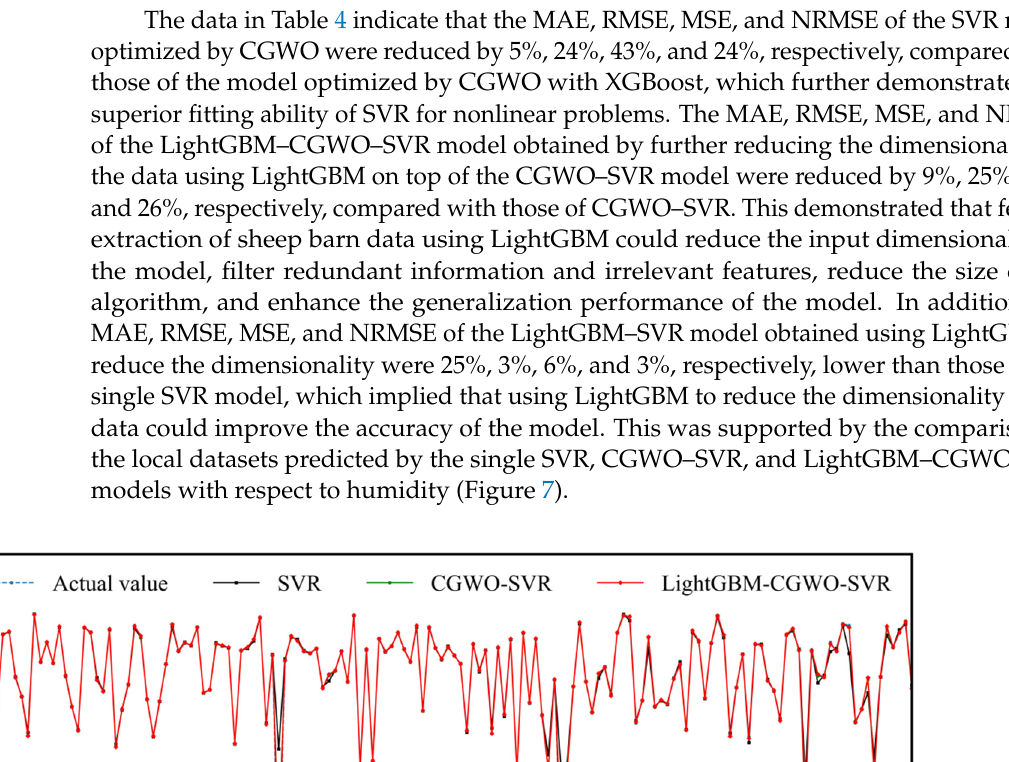
Figure 6. Measured versus computed humidity of GA–SVR, GWO–SVR, and CGW–SVR (part of validation data).